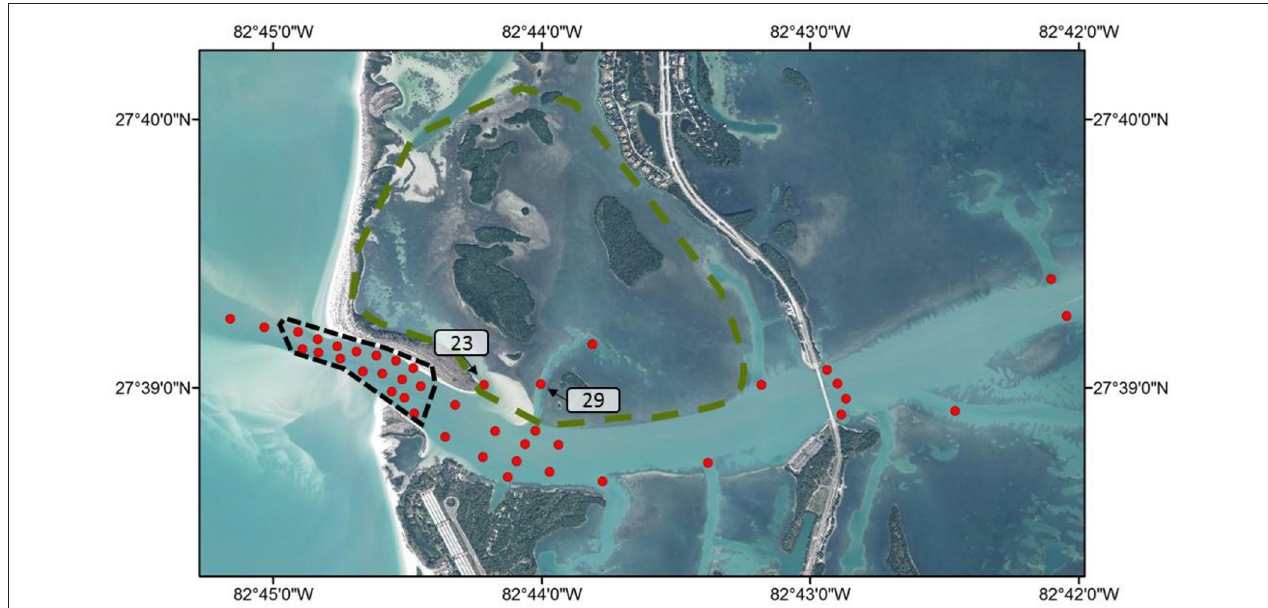
FIGURE 1 | Map of the focal spawning area. Region within the gray dashed line represents the spawning site, and area within green dashed line represents the seagrass habitat. Red dots show the receiver array. Key receivers in Snook and Seatrout spatial networks are labeled for referencing.